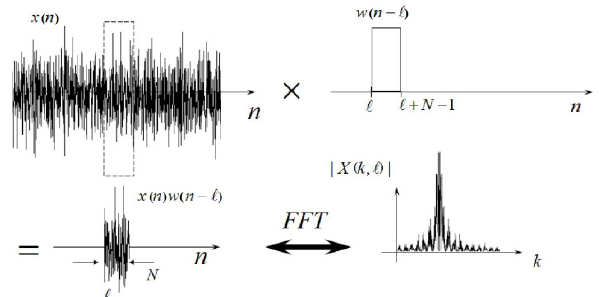
Figure 8. The diagram transformed into FFT signal